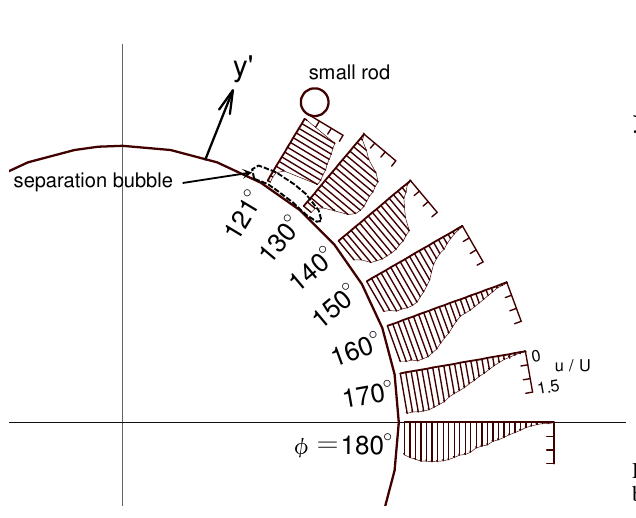
Fig. 8. Time-averaged velocity of the reattachment flow (D = 40 mm, d = 2 mm, G = 6 mm, a = 121°, Re = 4.2 · 10 4 ) .